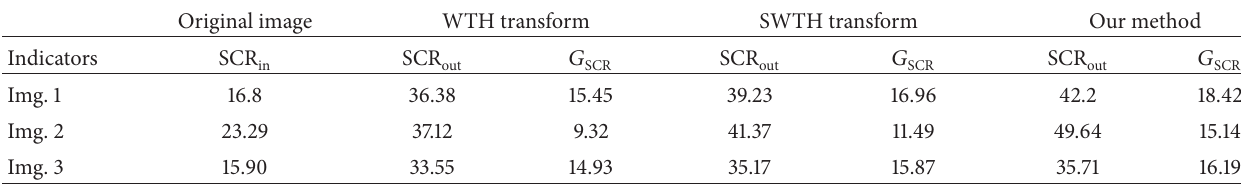
Table 1: Comparison of three background suppression